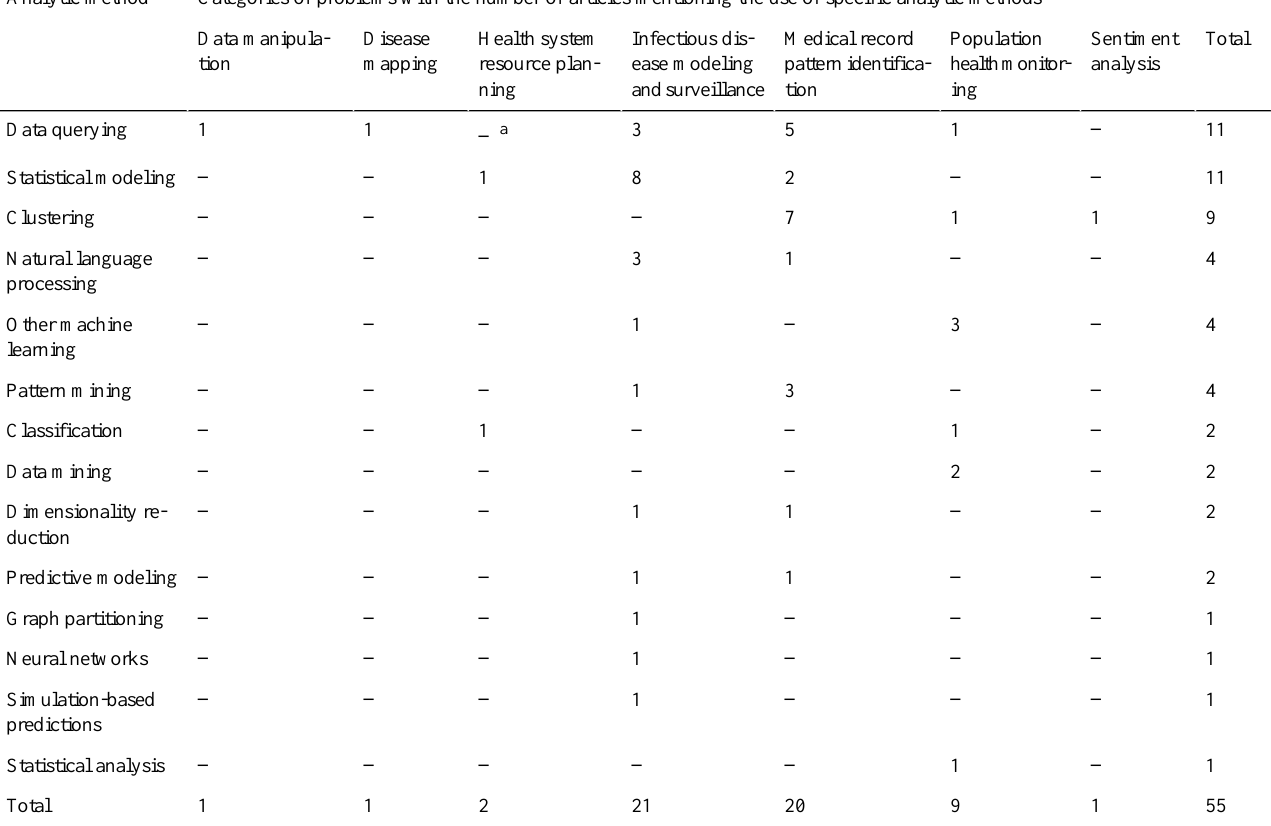
Table 5. Problem categories and major analytic methods. Categories of problems with the number of articles mentioning the use of specific analytic methodsAnalytic